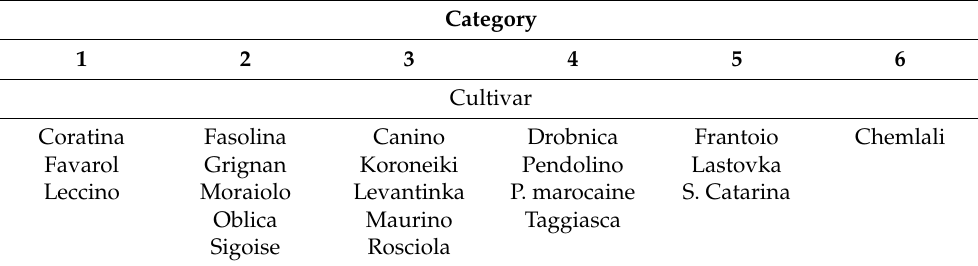
Table 1. The classification of 21 olive cultivars in six categories according to their tolerance to olive knot disease (from category 1–the highest tolerance to category 6–the lowest tolerance). The categories correspond to percentages of area affected by disease (1. Nil: 0; 2. Very low: 1–20%; 3. Low: 20–40%; 4. Medium: 40–60%; 5. High: 60–80%; 6. Very high: 80–100% of area